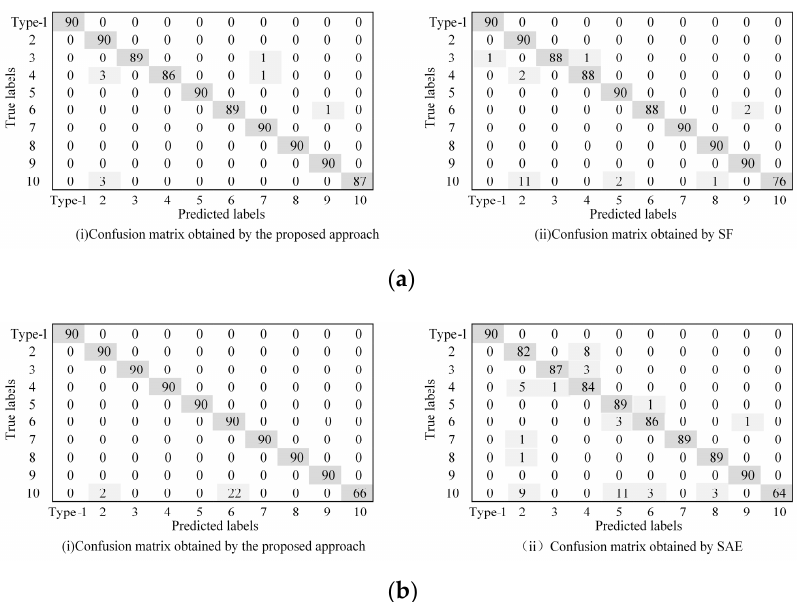
Figure 6. Comparison of the confusion matrixes obtained by different approaches. ( a ) Confusion matrix in case A. ( b ) Confusion matrix in case B.